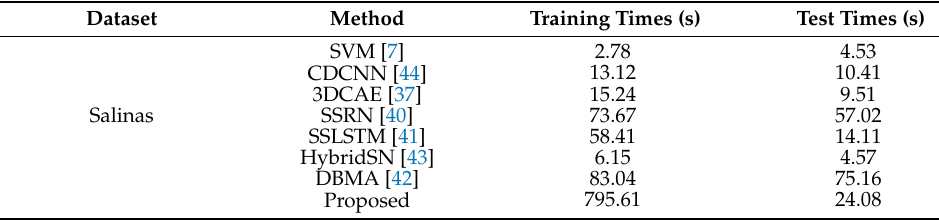
Table 13. Training and testing time on the Salinas